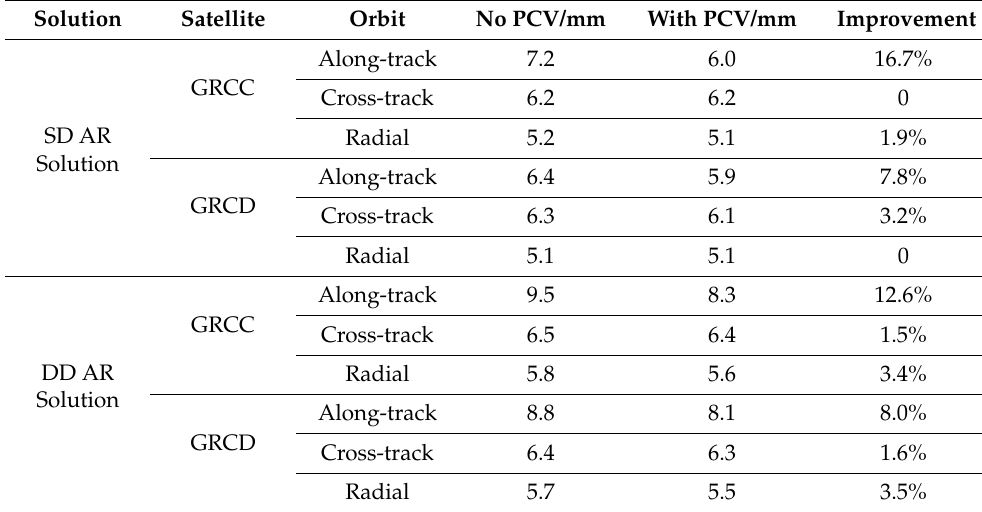
Figure 7. Daily RMSs of along-track orbit differences between JPL’s orbit and SD AR solution with (red dots) and without (blue dots) PCV corrections. The upper panel is for the GRCC satellite and lower panel is for the GRCD satellite. Table 3. Orbit improvements with application of PCV maps for SD AR and DD AR